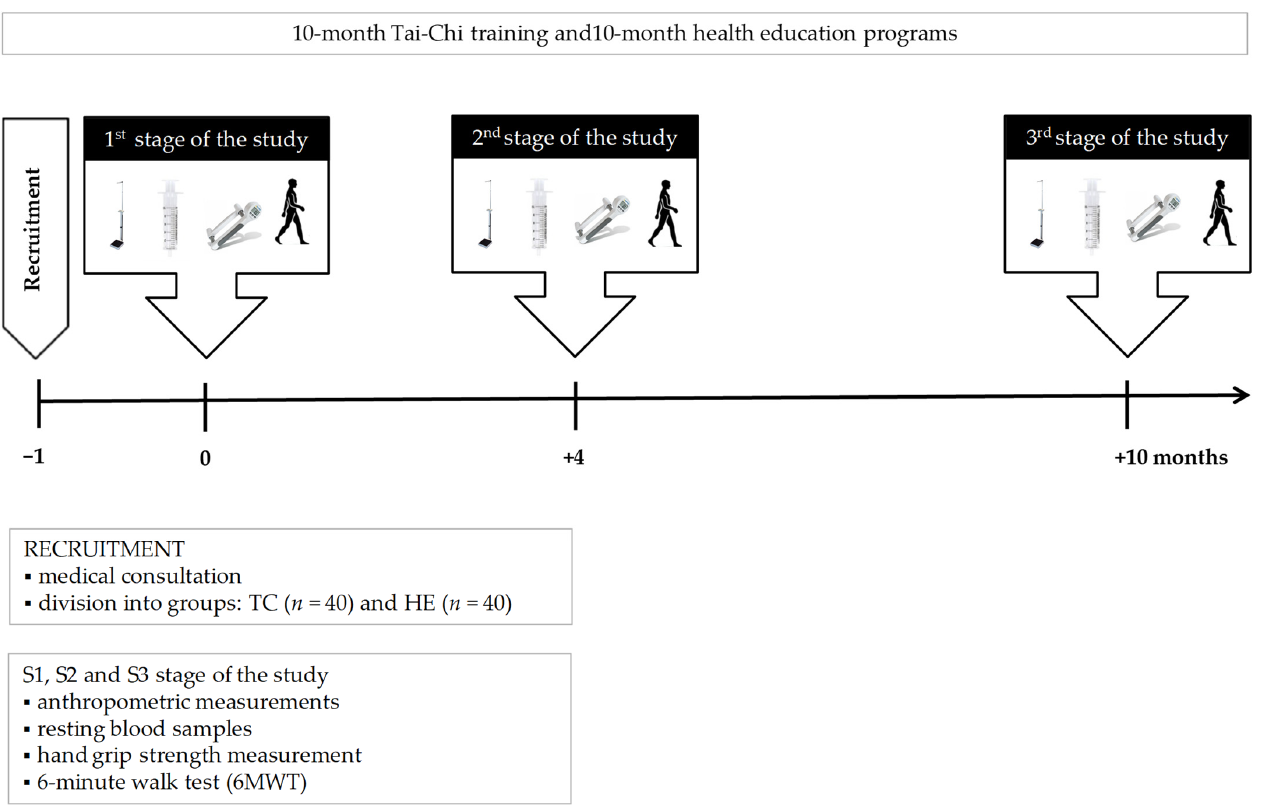
Figure 2. Illustration of the study design. Abbreviations: TC: Tai-Chi training, HE: health education.